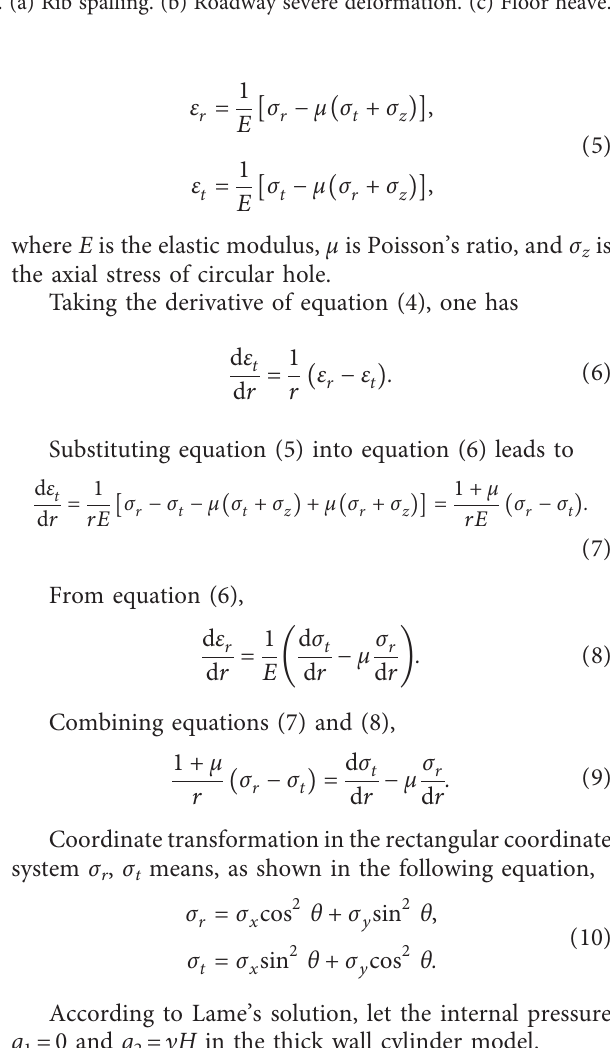
Figure 1: Damage to surrounding rock caused by high ground stress. (a) Rib spalling. (b) Roadway severe deformation. (c) Floor heave.